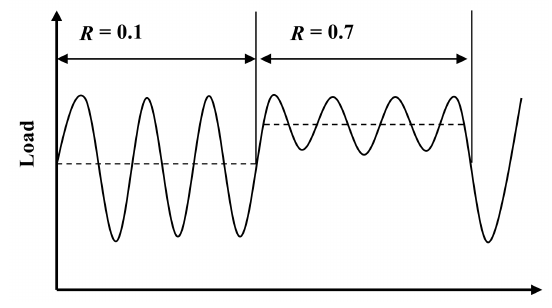
Figure 3. The loading spectrum.